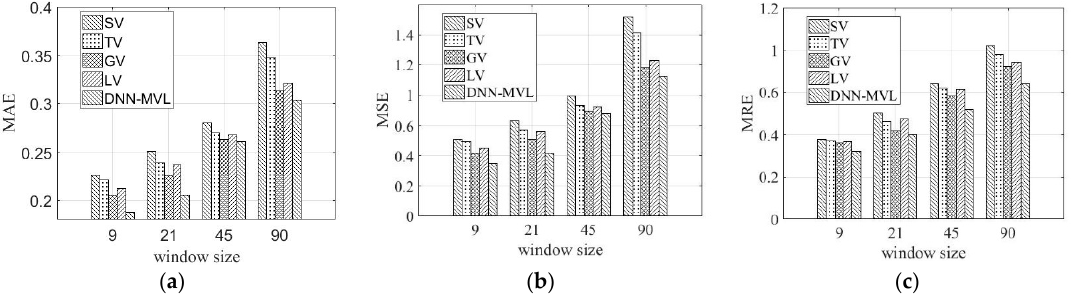
Figure 9. Performances of different views’ combinations. ( a ) MAE; ( b ) MSE; ( c ) MRE.